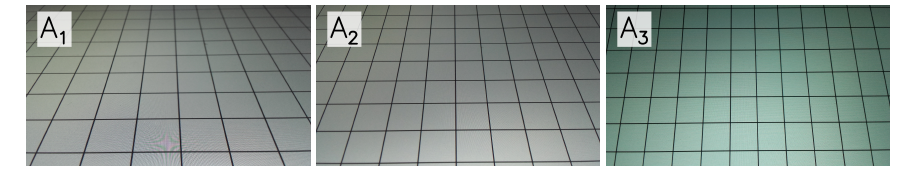
Figure 3. Angles A 1 ( τ ∼ 55 ◦ ), A 2 ( τ ∼ 40 ◦ ), and A 3 ( τ ∼ 15 ◦ ) to analyze the influence of obliquity.